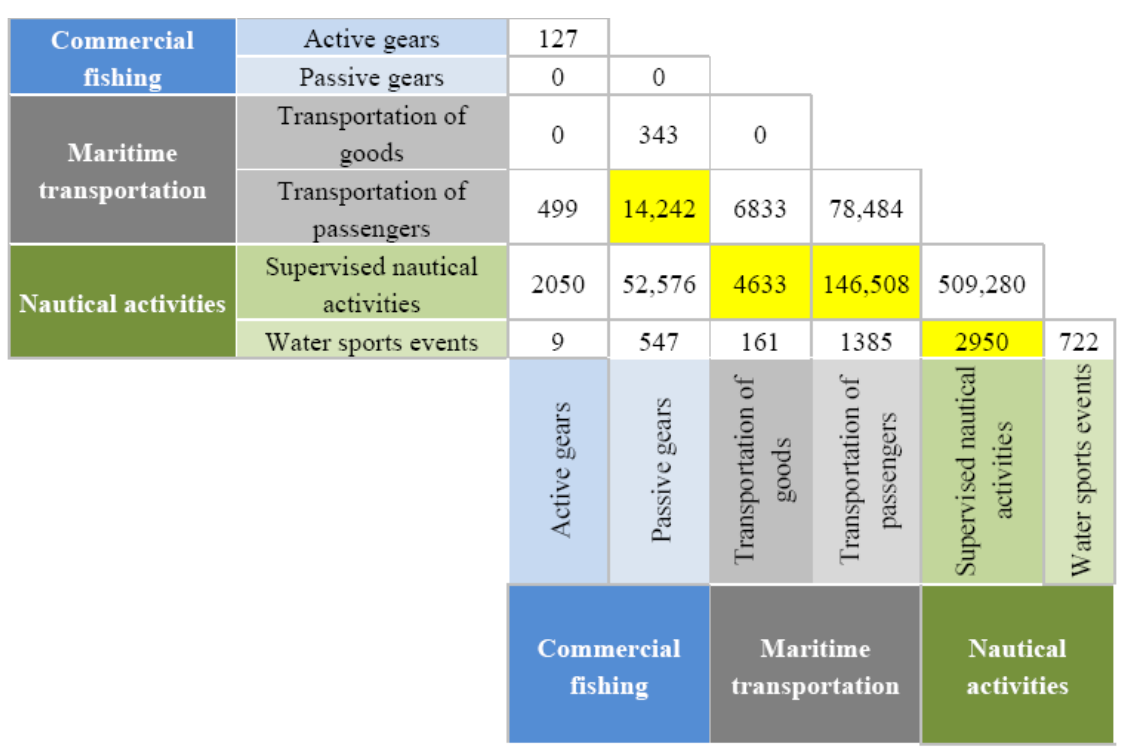
Figure 6. Spatio-temporal intersections among main types of supervised maritime activities (2009, Bay of Brest). Spatial intersections between the activity zones were performed at a daily time step. Negative spatio-temporal intersections are quoted in yellow.